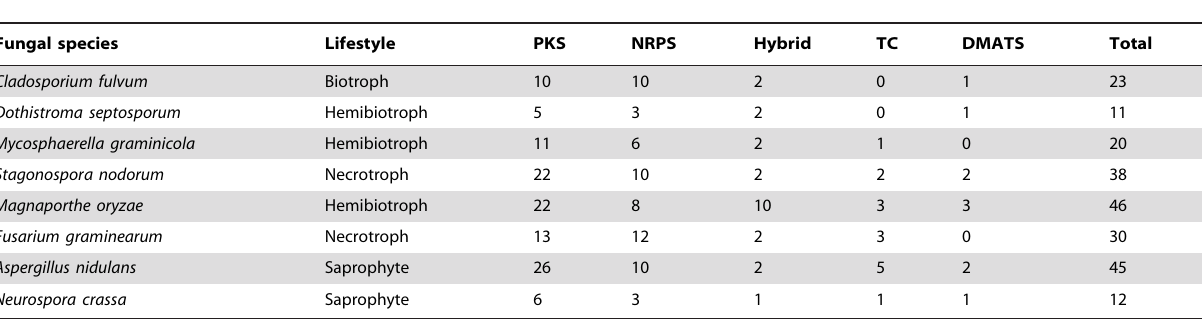
Table 7. Key secondary metabolism genes in Ascomycete genomes.